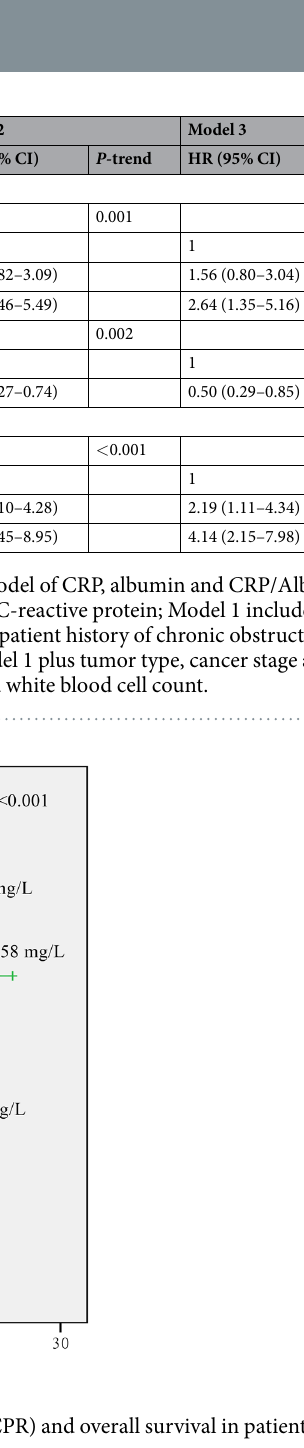
Figure 1. The relationship between C-reactive protein (CPR) and overall survival in patients with non-small cell lung